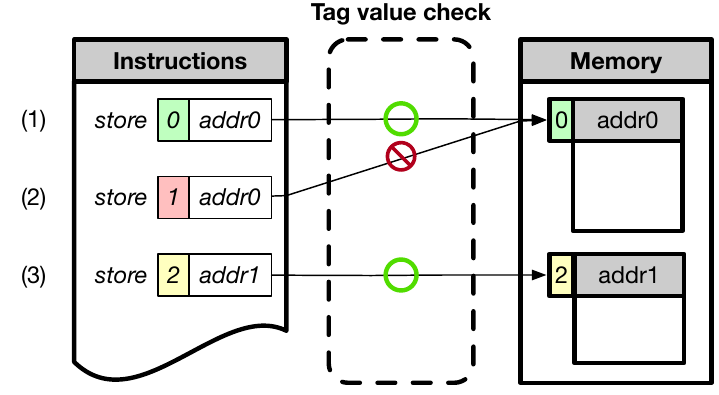
Figure 1. Overview of RISC-V